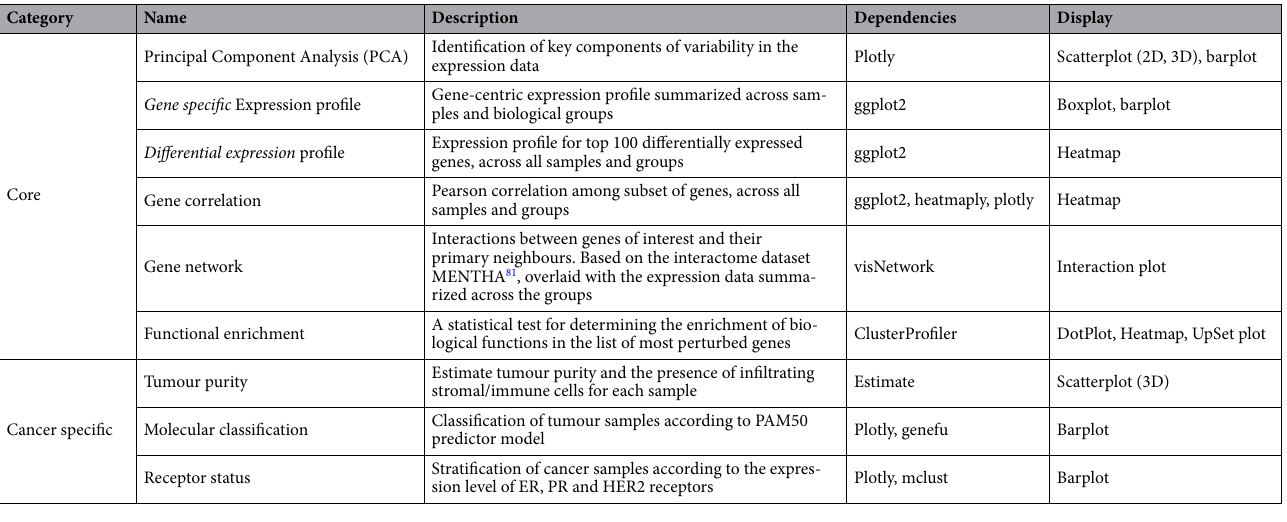
Table 1. Description of bioinformatics analysis available in